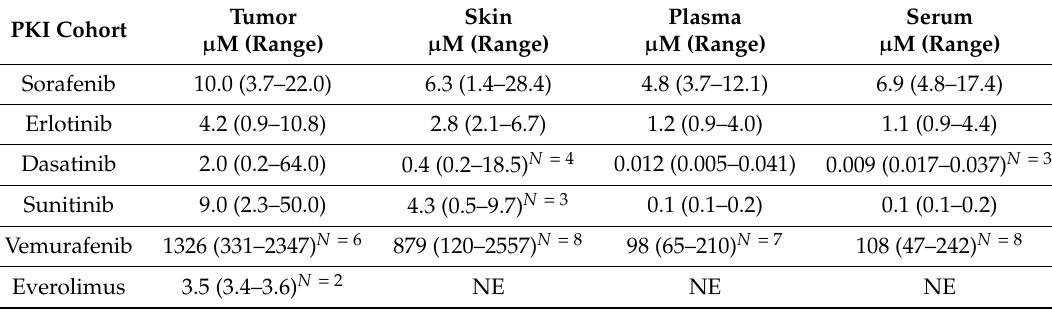
(Table S2). In this dataset, a total of 37,806 peptides were identified, of which 2326 were phosphorylated (6%). Identified and quantified phosphopeptides and – sites can be found in Tables S3 and S4. Table 2. Summary of PKI concentrations after 2 weeks of treatment. PKI concentrations in tumor, skin, plasma and serum per cohort, determined by LC-MS after 10–14 days of treatment. Numbers depict median and range of concentrations based on 5 patients per cohort, unless otherwise indicated. NE, not evaluable. Achieved plasma and serum concentrations at t = 1 week (data not shown) and t = 2 weeks of treatment were highly comparable. Results for individual patients are shown in Table